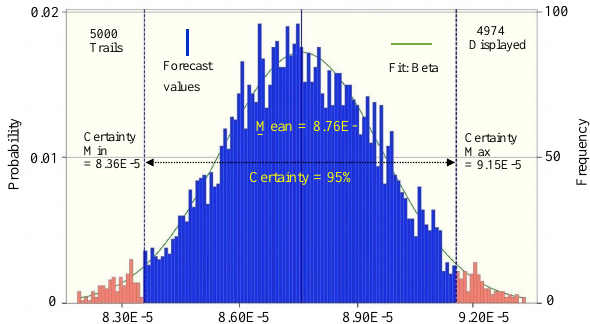
Figure 8. Probability distributions of hazard quotient of PBDEs in Monte Carlo simulations with 5000